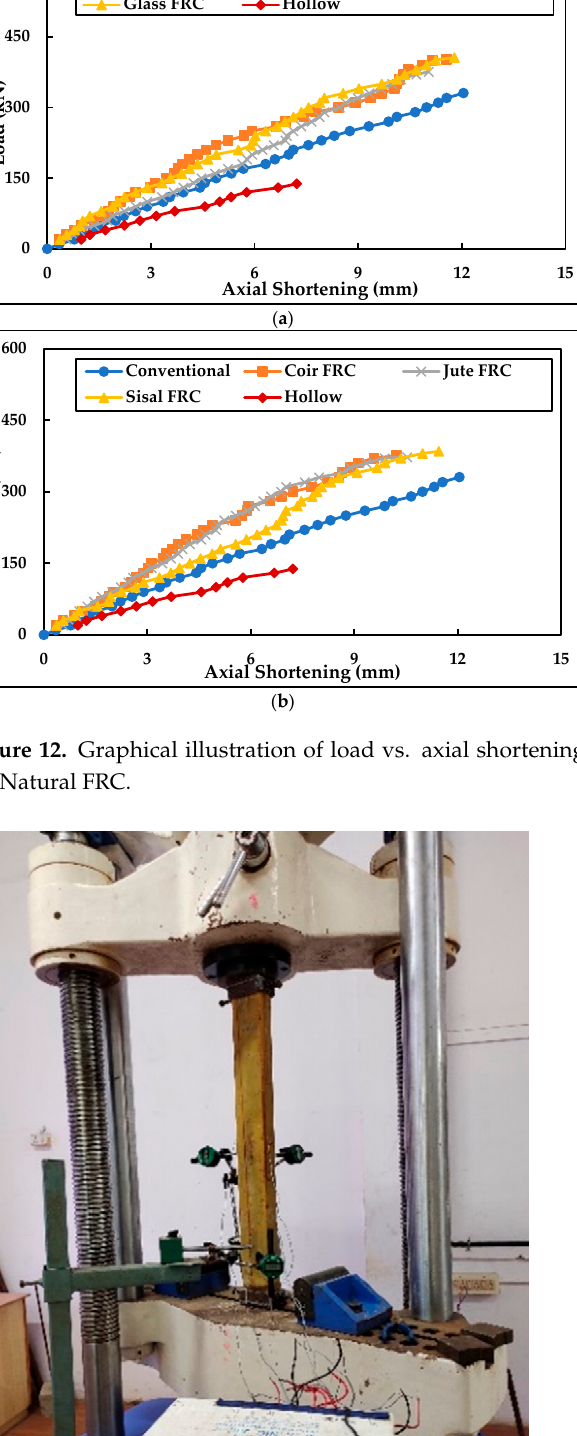
Figure 13. Failure in short columns.